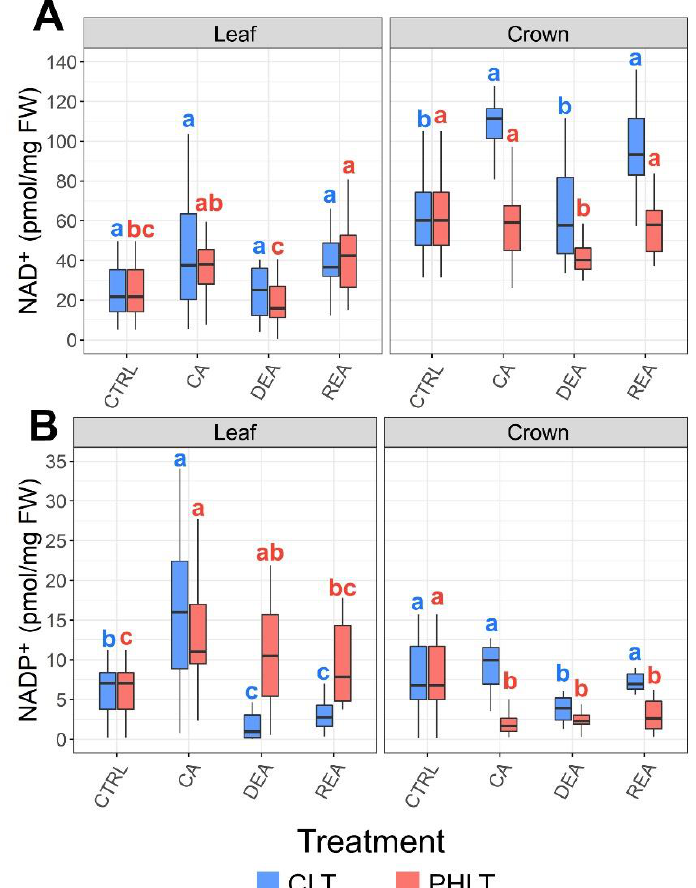
Figure 4. The effect of cold acclimation (CA), deacclimation (DEA), and reacclimation (REA) on accumulation of oxidised nicotinamide adenine dinucleotide (NAD + ) ( A ) and oxidized nicotinamide adenine dinucleotide phosphate (NADP + ) ( B ) in leaf and crown tissues of winter wheat under two low-temperature treatments. The letters above the boxplots indicate significant ( p < 0.05) differences between stages of acclimation within each tissue type and treatment group. CLT — constant low-temperature treatment during CA; PHLT — prolonged higher low-temperature treatment during CA. The control (CTRL) sampling point preceded the acclimation treatments; therefore, the concentrations at this stage are identical.